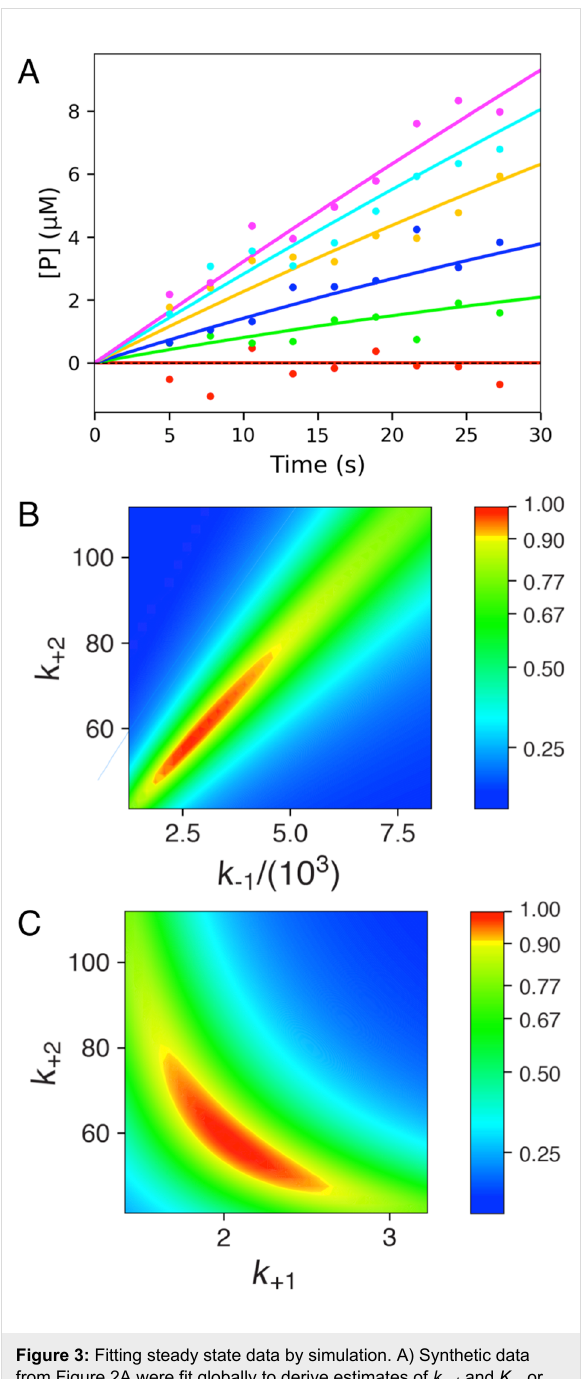
Figure 3: Fitting steady state data by simulation. A) Synthetic data from Figure 2A were fit globally to derive estimates of k cat and K m or k cat and k cat / K m as described in the text. B) Confidence contour analy- sis from fitting to derive k cat and K m . C) Confidence contour analysis from fitting to derive k cat and k cat / K m . The bar gives the color coding for the normalized χ 2 values